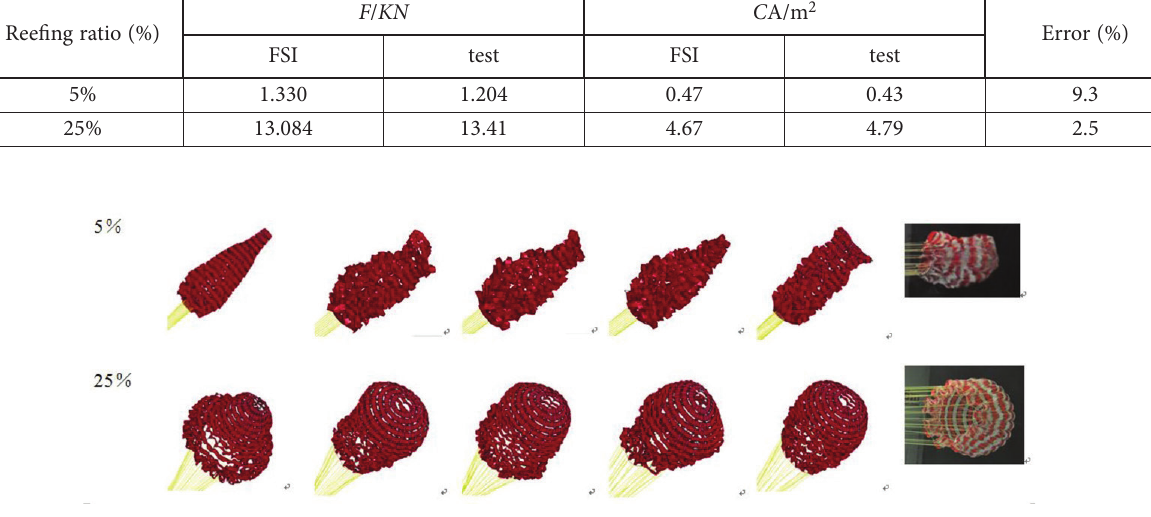
Figure 3. Change of the canopy shape during inflation (t = 0.1, 0.3, 0.5, 0.7, 0.9